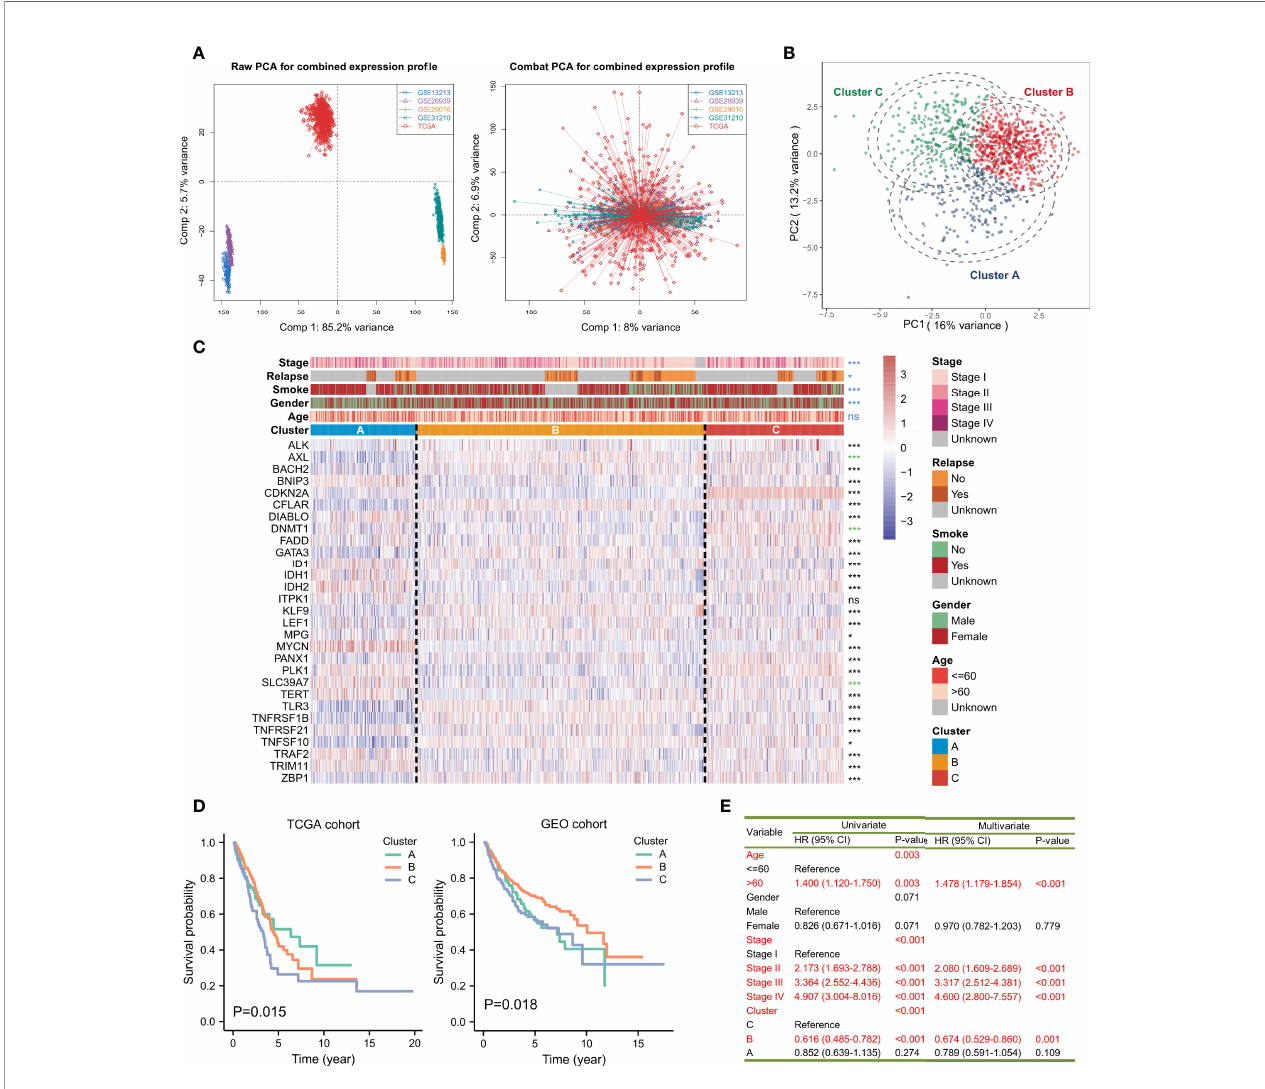
FIGURE 2 | Average-linked and K-means-based unsupervised clustering to determine three necroptosis phenotypes. (A) Principal component analysis (PCA) showed the distribution of transcriptional expressions of the 29 necroptosis-related genes in fi ve lung adenocarcinoma cohorts before (left part) and after (right part) the batch effect correction. (B) PCA indicated that the expression pro fi les of the 29 necroptosis molecules could distinguish necroptosis phenotypes in the TCGA and GEO-meta cohorts. (C) The heatmap showed the correlations between the three necroptosis phenotypes and clinicopathologic features, and the expression changes of the 29 necroptosis-related genes. Asterisks represented p-value (***p < 0.001, *p < 0.05 and ns was the abbreviation of no signi fi cance), the color of which represented methods of statistical tests. Blue denoted Fisher ’ s exact test, black denoted Kruskal-Wallis test, and green denoted Welch one-way ANOVA test. The inner color of each cell demonstrated the expression variations. Redder was connected with overexpressed levels and bluer was linked with lower levels. (D) Kaplan-Meier curves and log-rank test showed signi fi cant differences of survival rate differences among the three necroptosis clustering subtypes in the TCGA and GEO-meta cohorts, respectively. (E) A univariate and multivariate Cox model revealed the prognostic in fl uences of necroptosis subtypes on overall survival outcomes in the TCGA